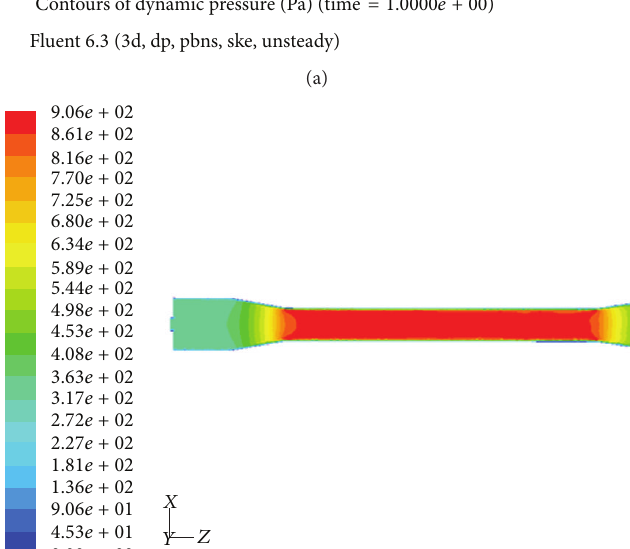
section of detonation tube can give better propulsion